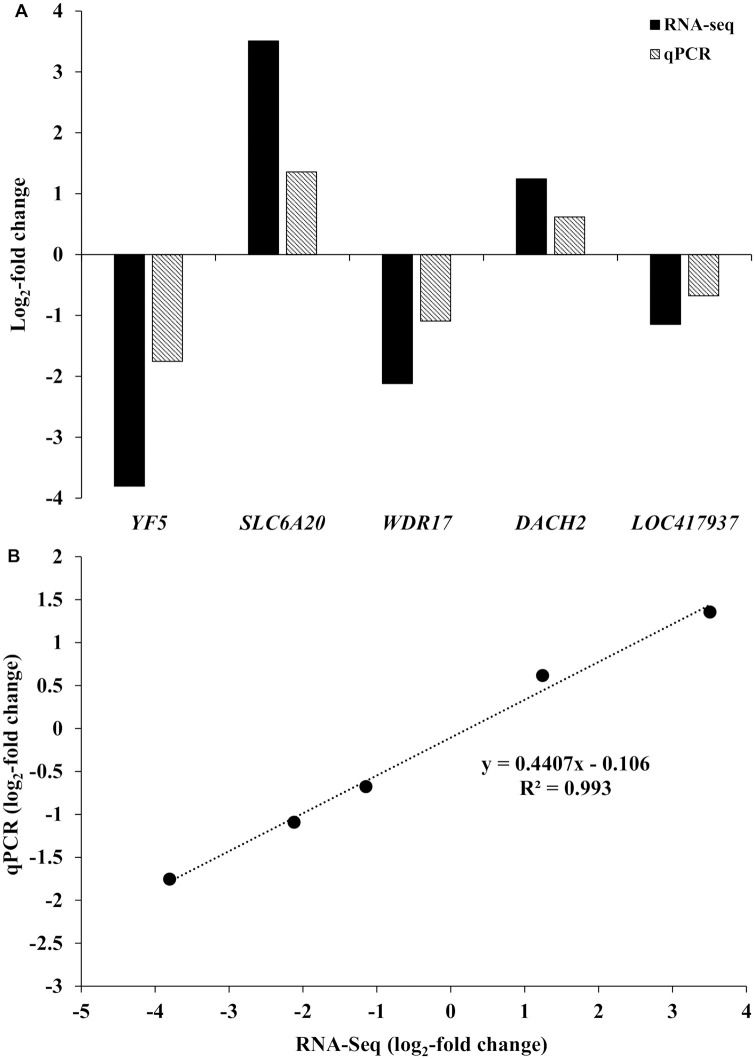
qPCR validation of differentially expressed genes (DEGs).The genes were differentially expressed in response to the interaction between heat stress and the form of supplemented methionine on whole blood, ileum, and liver. (A) X-axis represents 8 selected genes for qPCR and Y-axis represents the log2-fold change from RNA-seq and qPCR. (B) Regression analysis of the log2-fold change values between RNA-seq and qPCR.